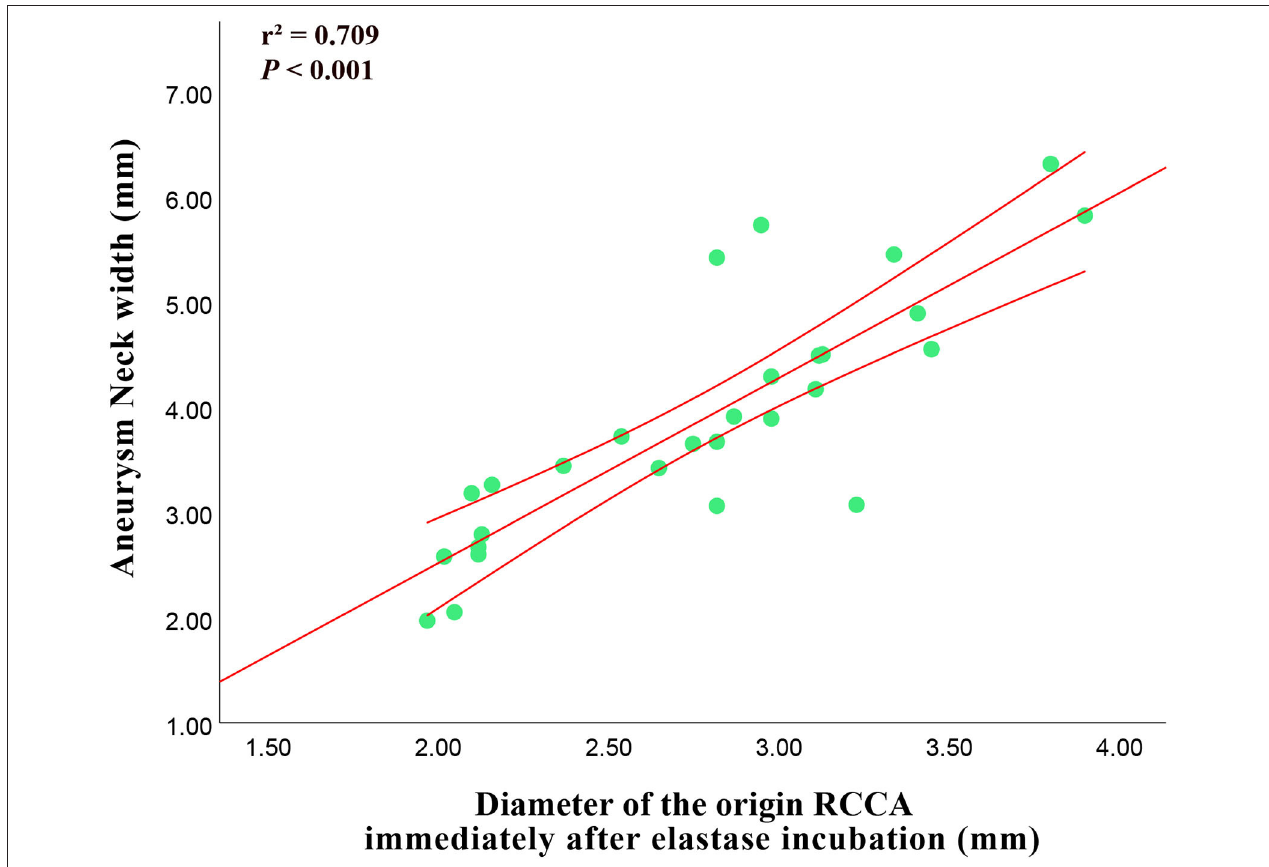
FIGURE 5 | Correlation between the diameter of the origin of RCCA immediately after elastase incubation and 3-week follow-up aneurysm neck